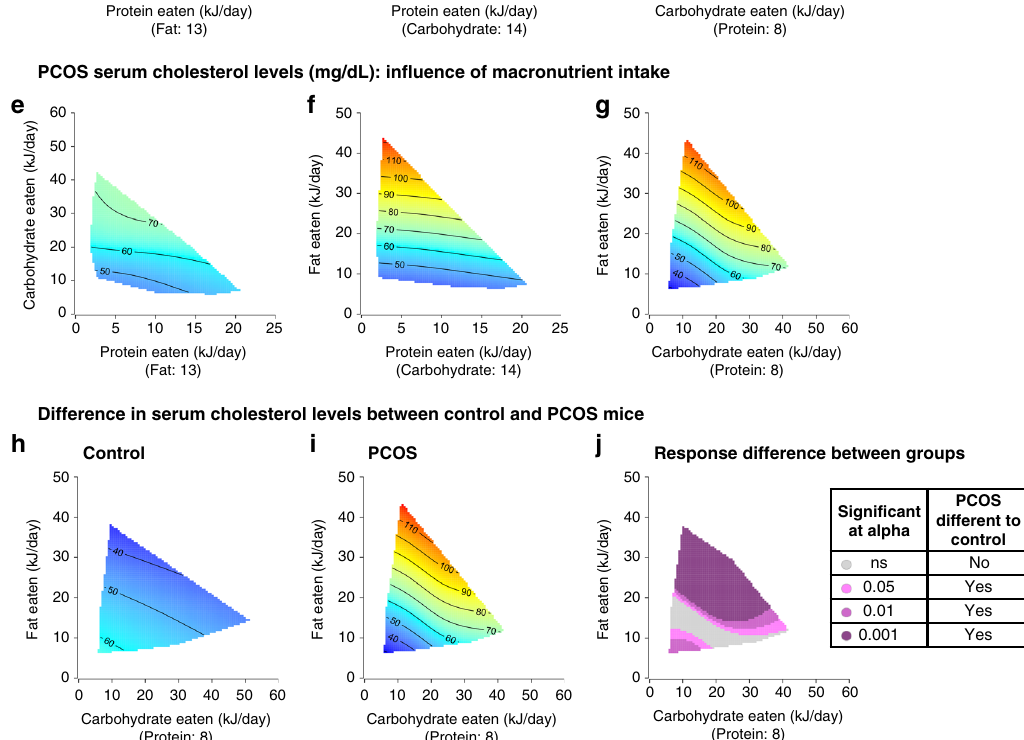
Fig. 5 Increased cholesterol level in PCOS mice is driven by PCOS pathophysiology and cannot be modulated via diet. a Serum cholesterol levels, showing that regardless of diet androgen excess leads to a non-signi fi cant increase in serum cholesterol levels ( P = 0.06). Signi fi cance determined by Mann – Whitney test. Data presented as violin plots, doted lines indicate the median and dashed lines the 25 and 75% percentiles. b – g 3D GAM Response surfaces displaying the relationship between macronutrient intake (kJ/day) and serum cholesterol levels in control ( b – d ) and PCOS mice ( e – g ), showing that macronutrient intake had no in fl uence on cholesterol levels in control mice, while F intake was the main driver for increased serum cholesterol levels in PCOS mice ( f , g ). Red areas indicate the greatest value for each response, which then decreases to the lowest value as the color shifts to blue. h – j 3D GAM response surfaces showing the effects of C and F intakes on serum cholesterol levels in control mice ( h ), PCOS mice ( i ) and response difference ( j ), showing that overall cholesterol levels in PCOS mice are signi fi cantly different to control mice due to the underlying pathophysiology of PCOS. However, serum cholesterol levels in PCOS females reached comparable levels to control when F intake was reduced to <20 kJ/day. a – j n = 91 control and 89 PCOS valent in women with PCOS 58 . A meta-analysis showed that in an women with PCOS displayed higher levels of LDL-cholesterol